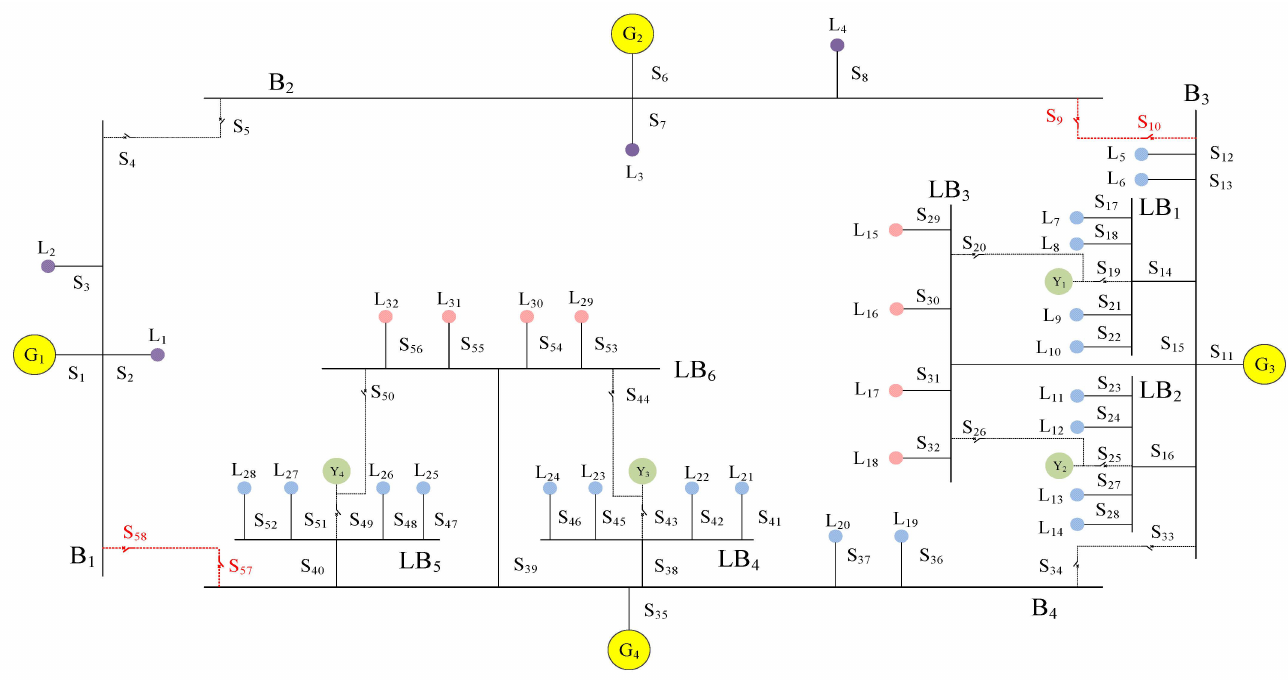
Figure 8. The initial system topology.